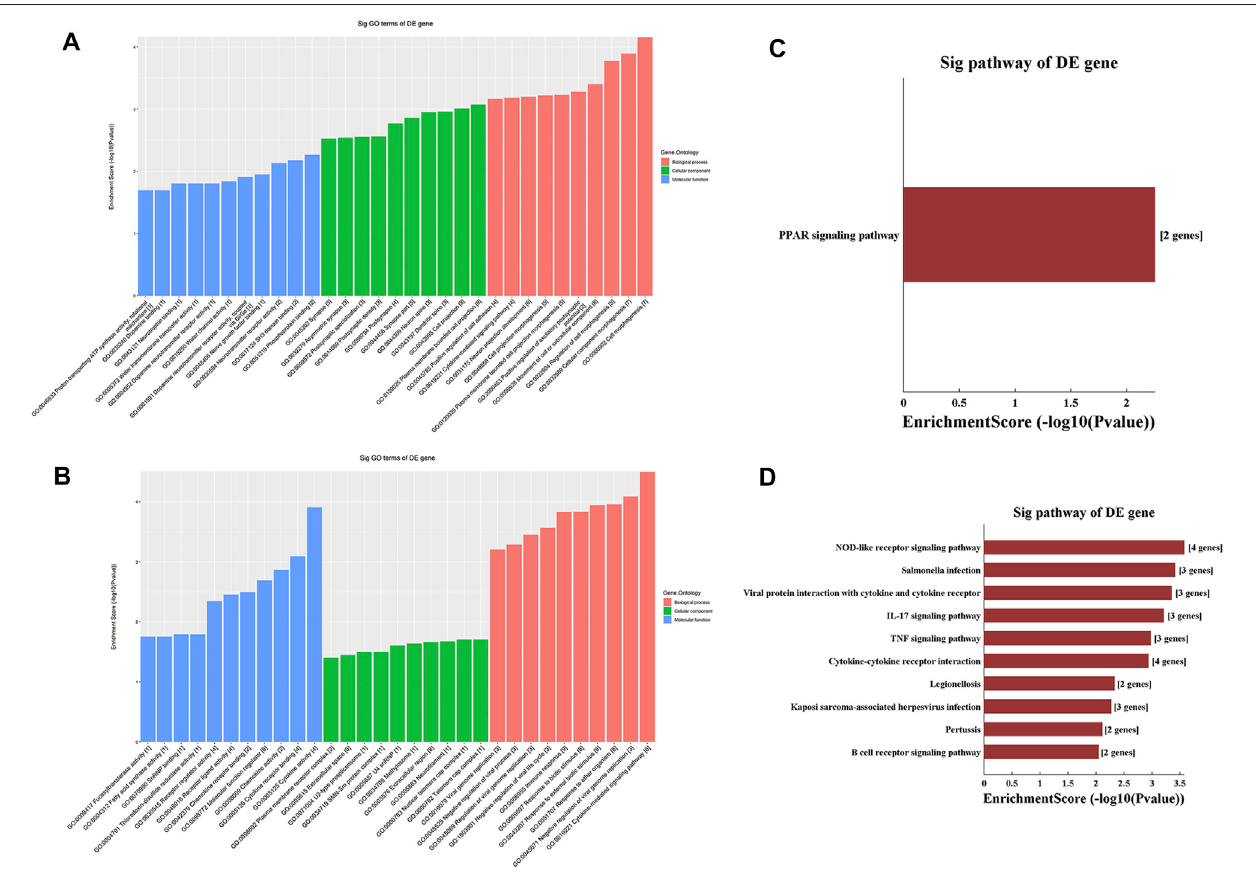
FIGURE 3 | Gene ontology enrichment and Kyoto Encyclopedia of Genes and Genomes analysis of altered m 6 A transcripts. (A) The top ten signi fi cantly enriched GO terms of upregulation m 6 A transcripts. (B) The top ten signi fi cantly enriched GO terms of downregulation m 6 A transcripts. (C) The signi fi cantly enriched KEGG pathways of upregulation m 6 A transcripts. (D) The signi fi cantly enriched KEGG pathways of downregulation m 6 A transcripts. GO, Gene ontology; KEGG, Kyoto Encyclopedia of Genes and Genomes. DE, differentially expressed.